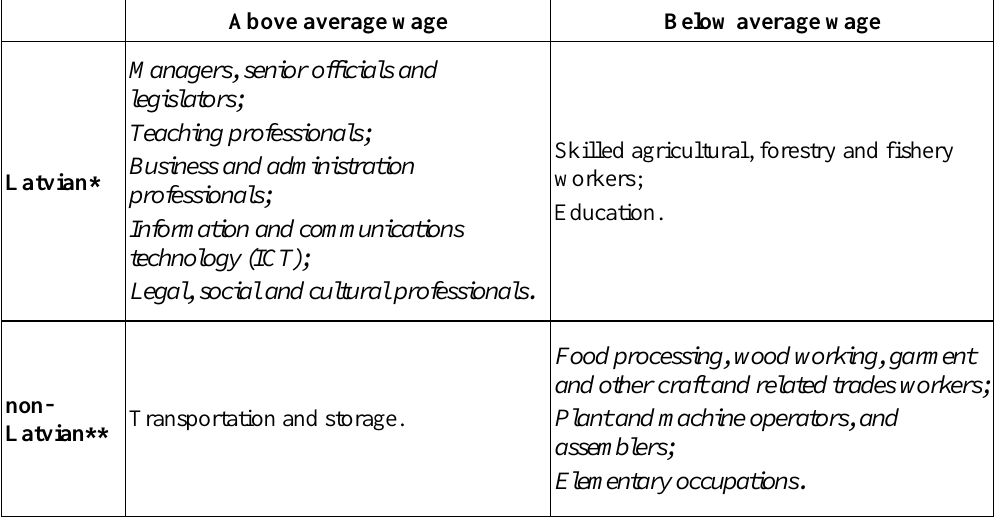
Table 1. Occupations and Sectors which Significantly Contributed to Ethnic Wage Gap in 2015 Above average